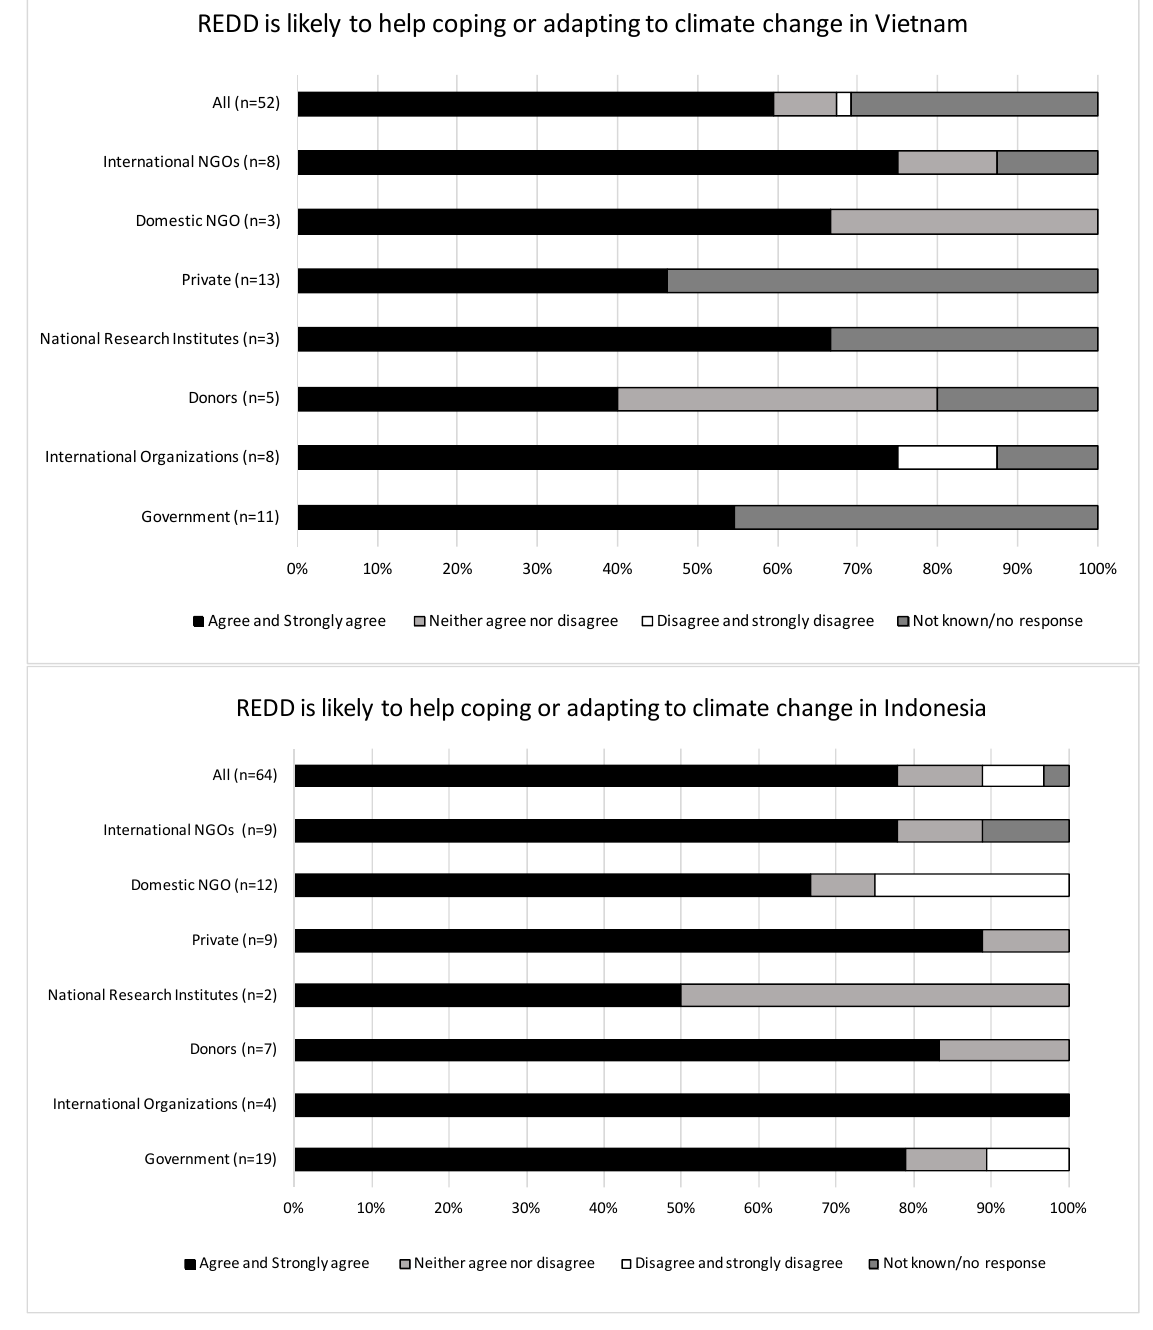
Figure 2. Actors’ views on whether REDD+ can support efforts to adapt to climate change, by type of